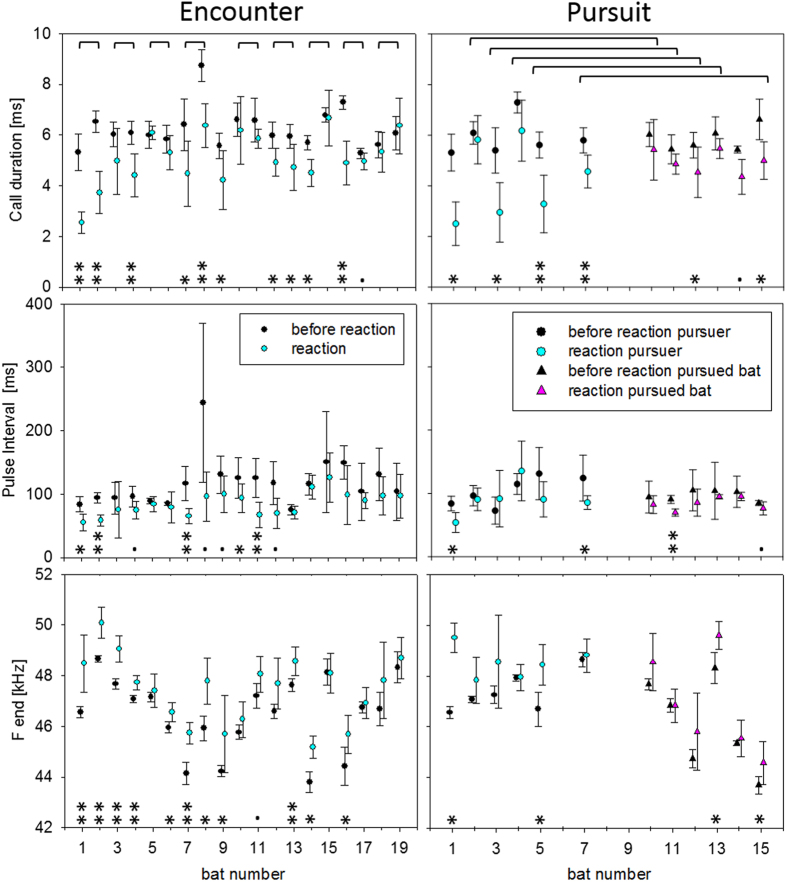
Reactions to conspecifics as indicated by changes in call duration, pulse interval and terminal frequency.For all bats reacting in flight to a conspecific the three call parameters (call duration, pulse interval and terminal frequency; mean ± s.d.) of the last five search calls before reaction (black) were compared with the parameters of the following five calls after beginning of the reaction (blue and pink). Data for encounters (bats fly towards each other) and pursuits (one bat flies behind the other) are presented separately. Pursuits are additionally separated into reactions of the pursuer (blue) and the pursued bat (pink). The inter-acting bat pairs are marked by parentheses above the data. The significance level of the comparison between parameters before and after beginning of reaction is indicated below (**p < 0.01; *p < 0.05;. = Trend (0.05 < p < 0.1)).